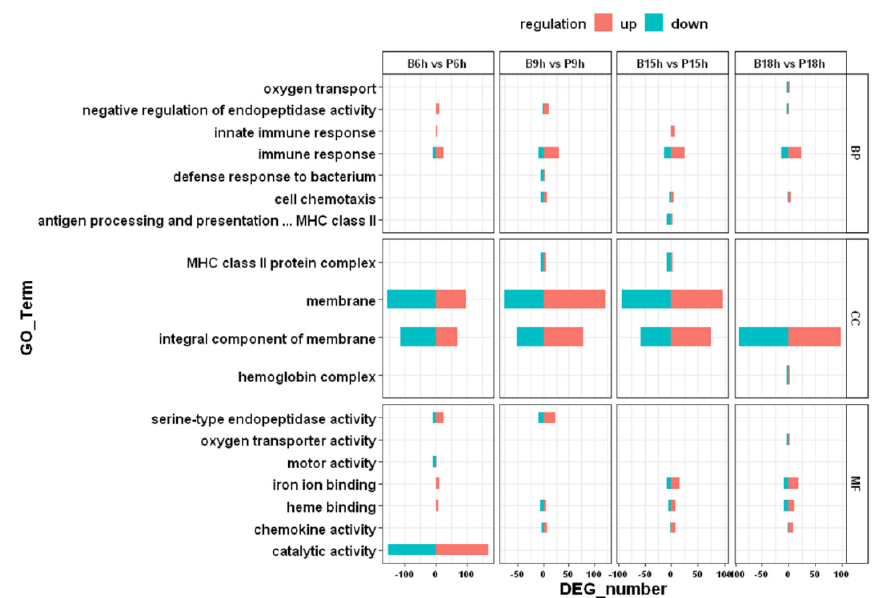
Figure 3. Top 18 significantly enriched GO terms in four comparisons (B6h vs. P6h, B9h vs. P9h, B15h vs. P15h, and B18h vs. P18h). BP: biological process; CC: cellular component; MF: molecular function.